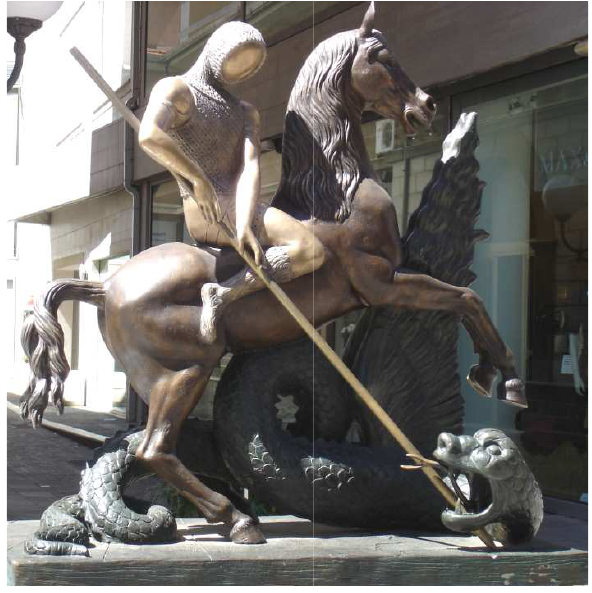
Figure 3. St. George and the